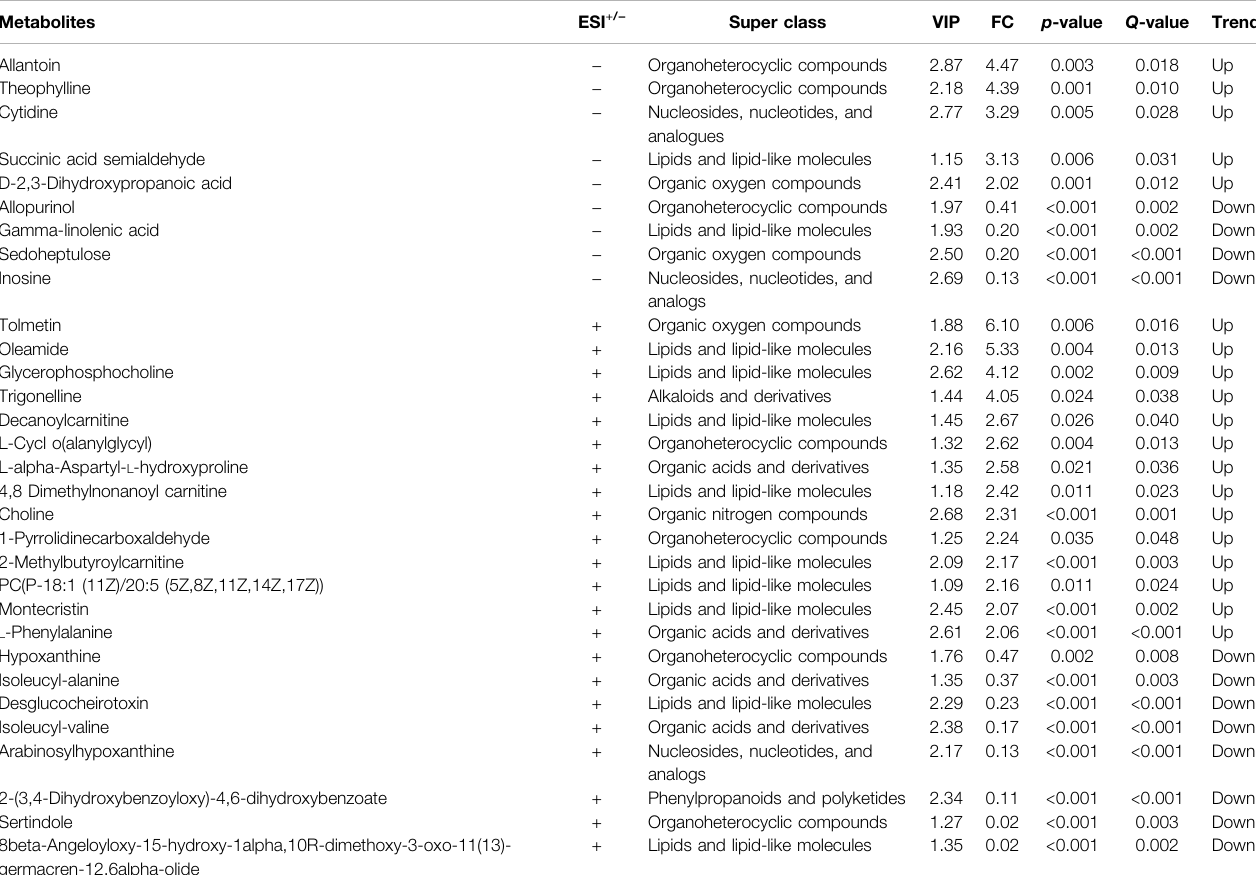
TABLE 3 | Altered metabolites in the serum between the EA group and the non-EA group undergoing elective surgeries under general anesthesia. Metabolites ESI + / − Super